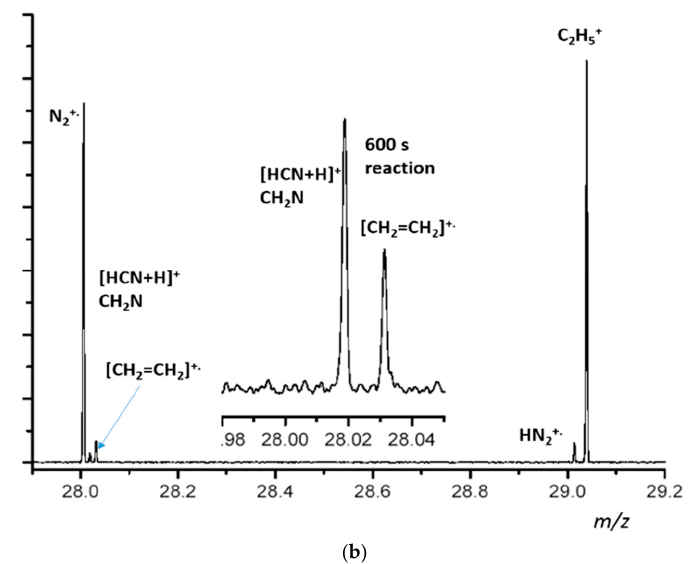
Figure 2. Detected reaction products obtained by a 15 s irradiation of a 95% N 2 /5% CH 4 mixture at 5·10 − 5 torr after a 2 s ( a ) and 600 s (inset in ( b )) reaction time in the ICR cell of a 4.7 T IonSpec instrument.